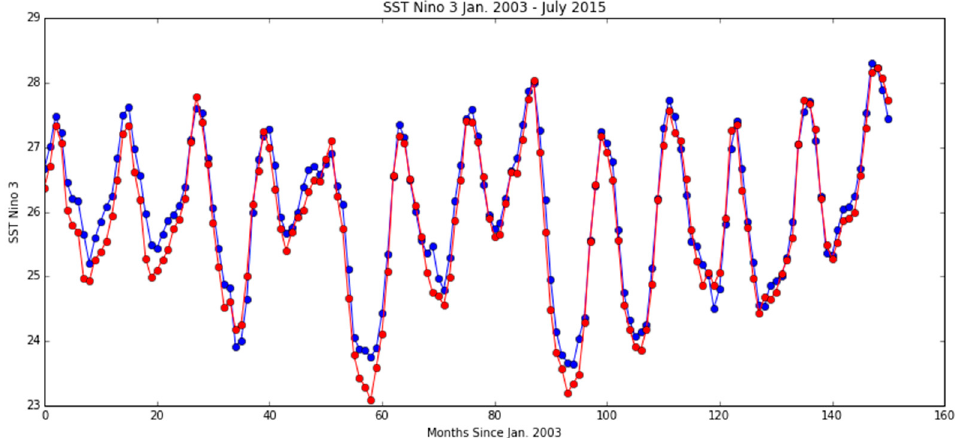
Figure 11. MIIC collected CERES SST observations (red) vs. NOAA monthly time series (blue) for Nino 3 the Central Tropical Pacific (5 ◦ N–5 ◦ S, 150 ◦ E–90 ◦ W); January 2003–July 2015; R = 0.99535, dif f = − 0.170 ◦ C, σ = 0.217 ◦